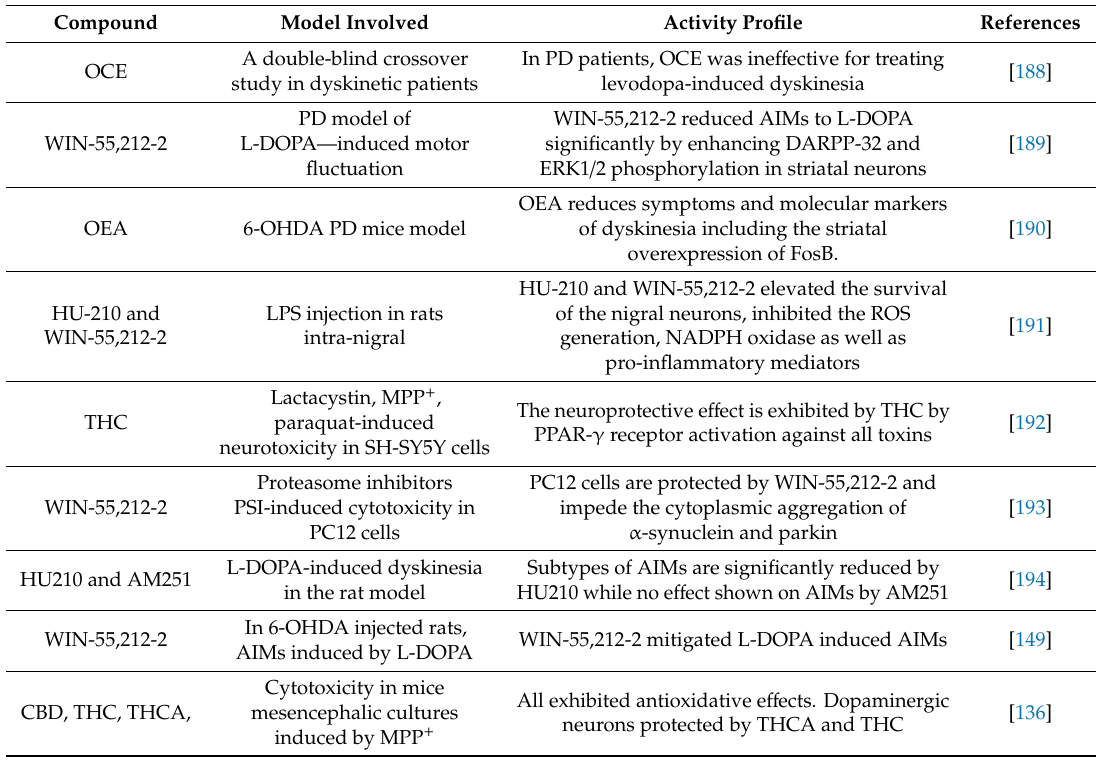
Table 2. A summarized form of di ff erent PD models demonstrating the pharmacological impact of numerous